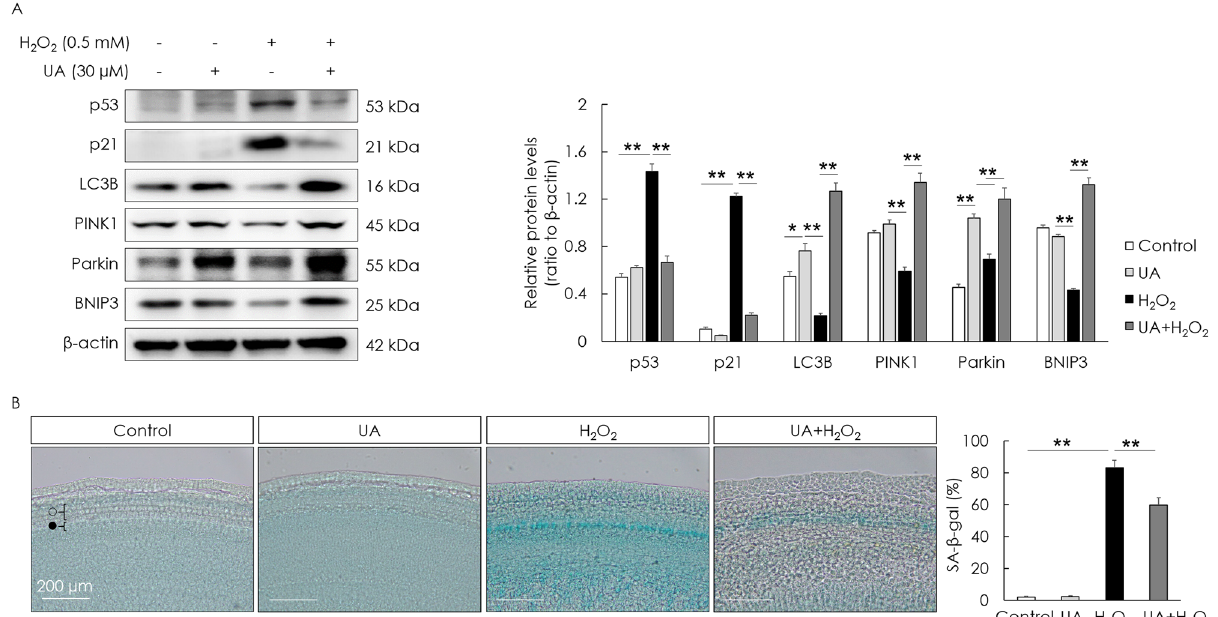
Figure 4. Effect of UA on levels of senescence- and mitophagy-associated molecules in cochlear explants. Cochlear explants were pre-treated with 30 µM UA for 2 h, and then incubated with 0.5 mM H 2 O 2 for 5 h, and Parkin, and BNIP3) following H 2 O 2 treatment of cochlear explants ( A ). UA pre-treatment significantly decreased the percentage of β-gal-stained cells following H 2 O 2 treatment of cochlear explants ( B ). Data